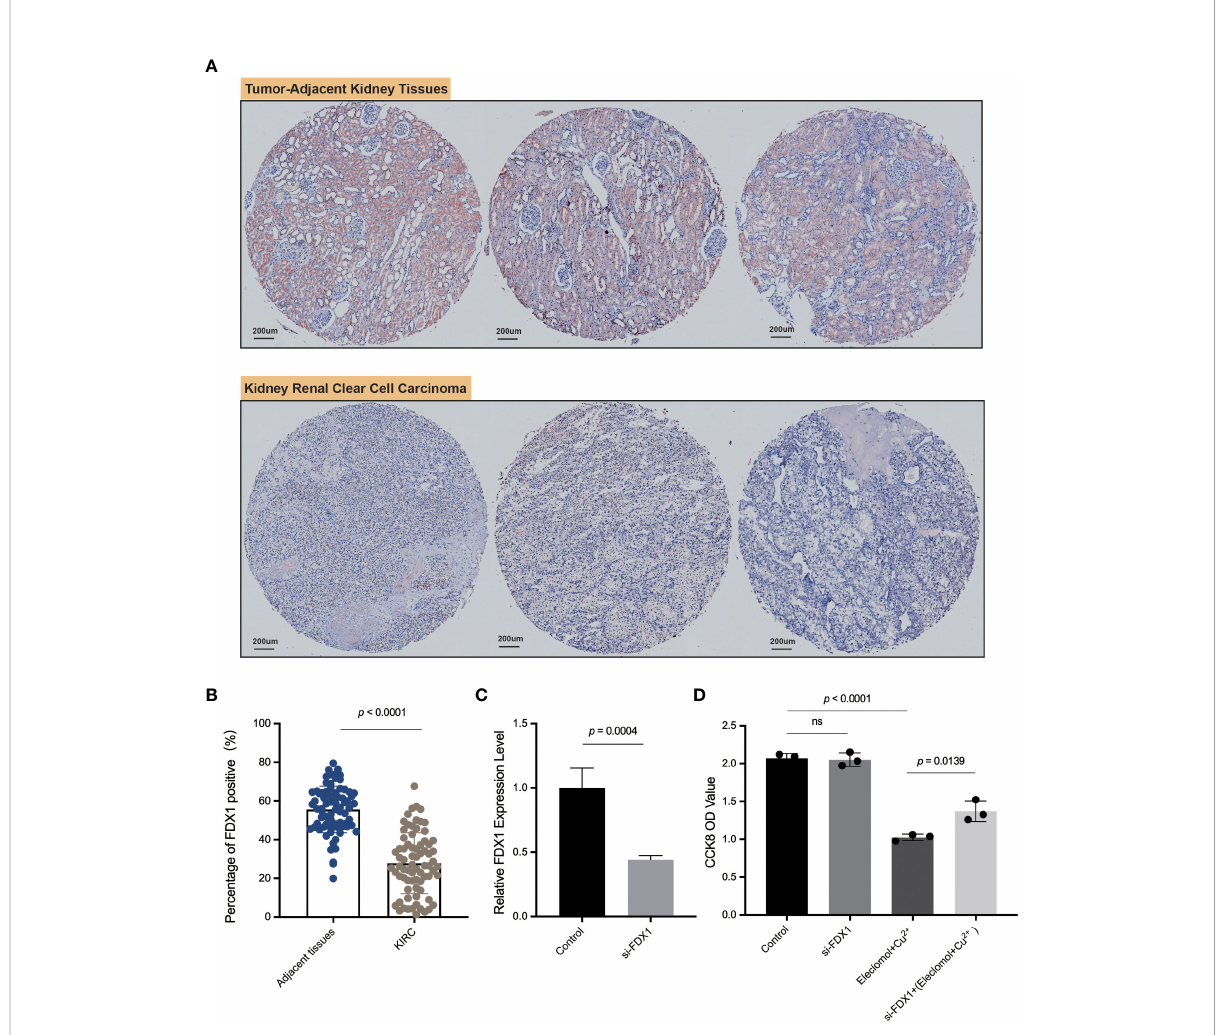
FIGURE 7 IHC of FDX1 in the kidney renal clear cell carcinoma tissue microarray and in vitro experiments. (A) The pictures of IHC under the microscope. The FDX1 -positive areas are tan-colored. (B) Comparison of the FDX1 -positive IHC areas between tumor and adjacent normal tissues based on ImageJ quanti fi cation. (C) The relative expression of FDX1 in 786-O cells transfected with si- FDX1 . (D) The cell growth OD value (450 nm) assessed by CCK-8 kit after 24 h with the addition of elesclomol+Cu 2+ . A higher OD value means more living cells. The elesclomol+Cu 2+ was used to induce cuproptosis. ns means not signi fi cant, p ≥